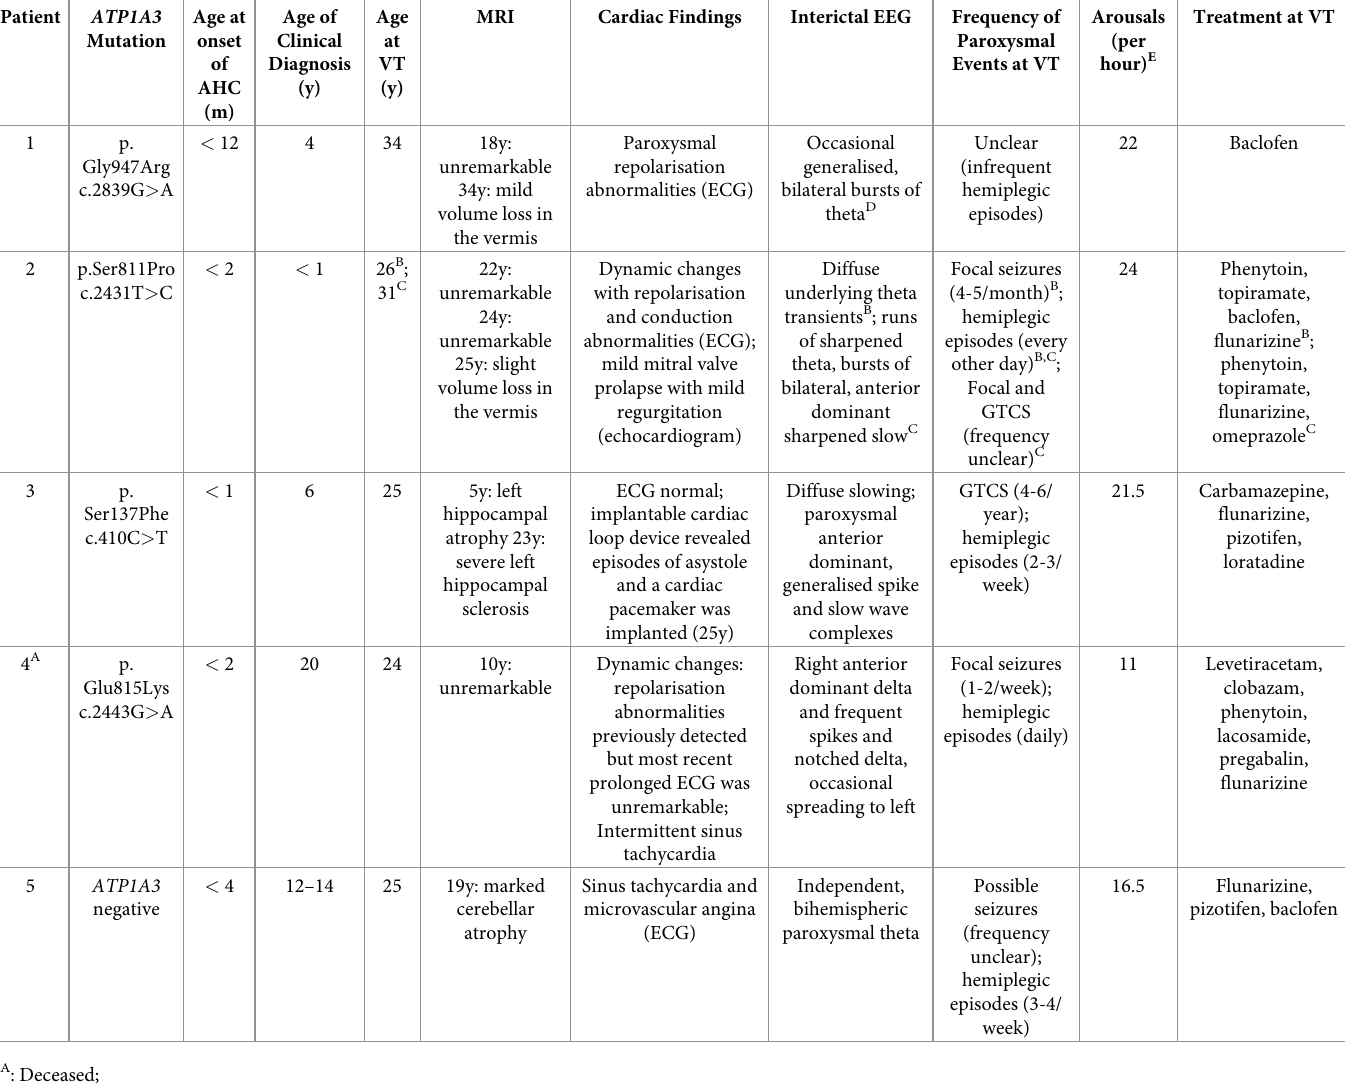
Table 1. Clinical characteristics of AHC